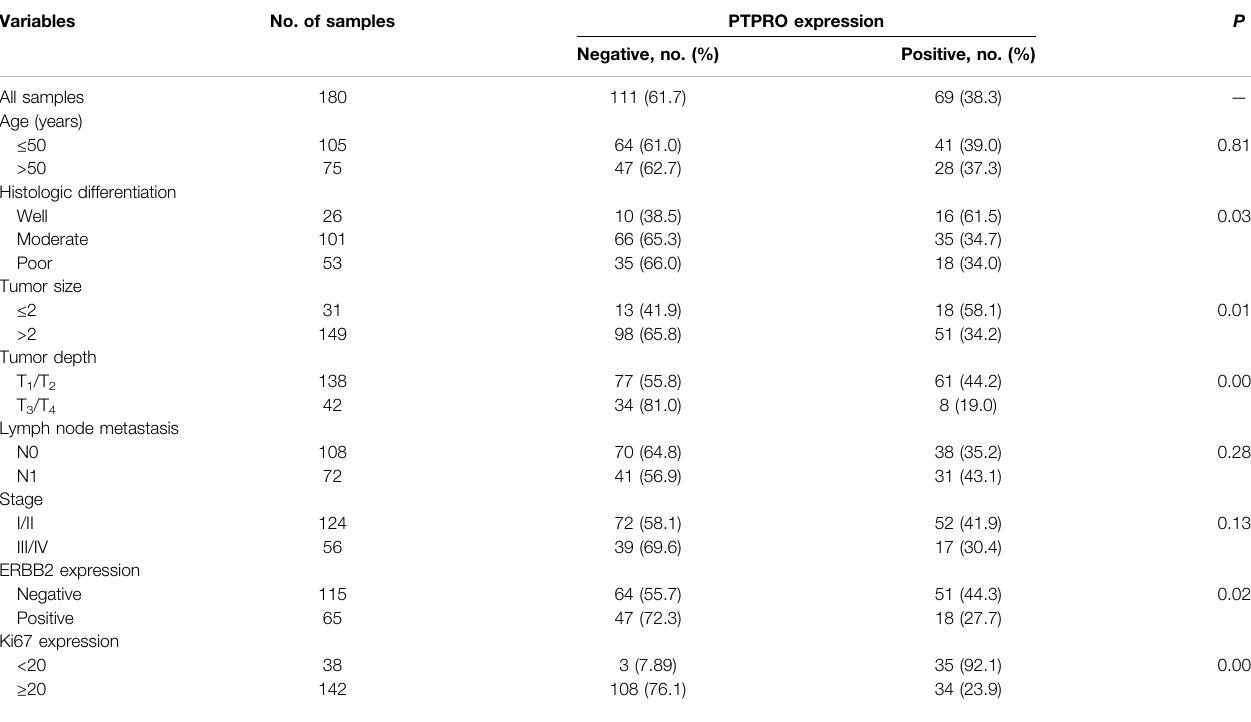
TABLE 1 | Relationship between PTPRO expression and clinicopathologic variables in tissue samples of breast cancer patients ( n = 180). Variables No. of